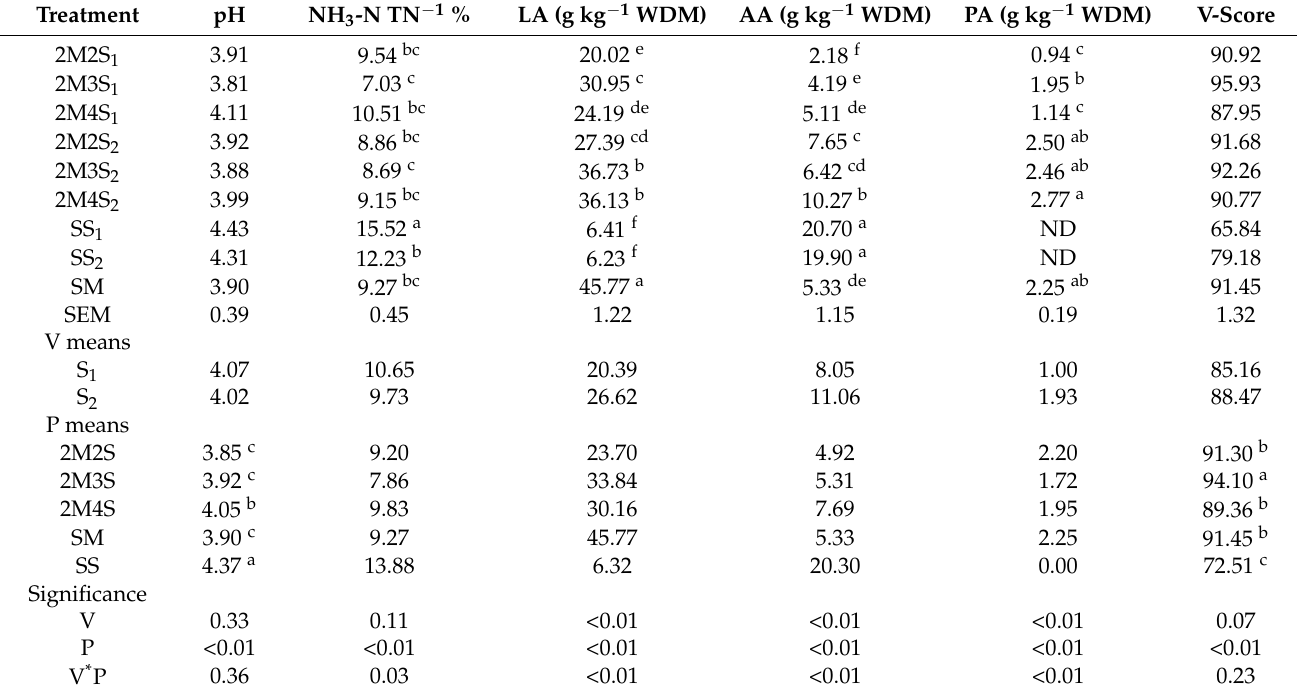
Table 6. Fermentation profiles of maize and soybean silage at 60 days of ensiling as affected by different planting patterns in